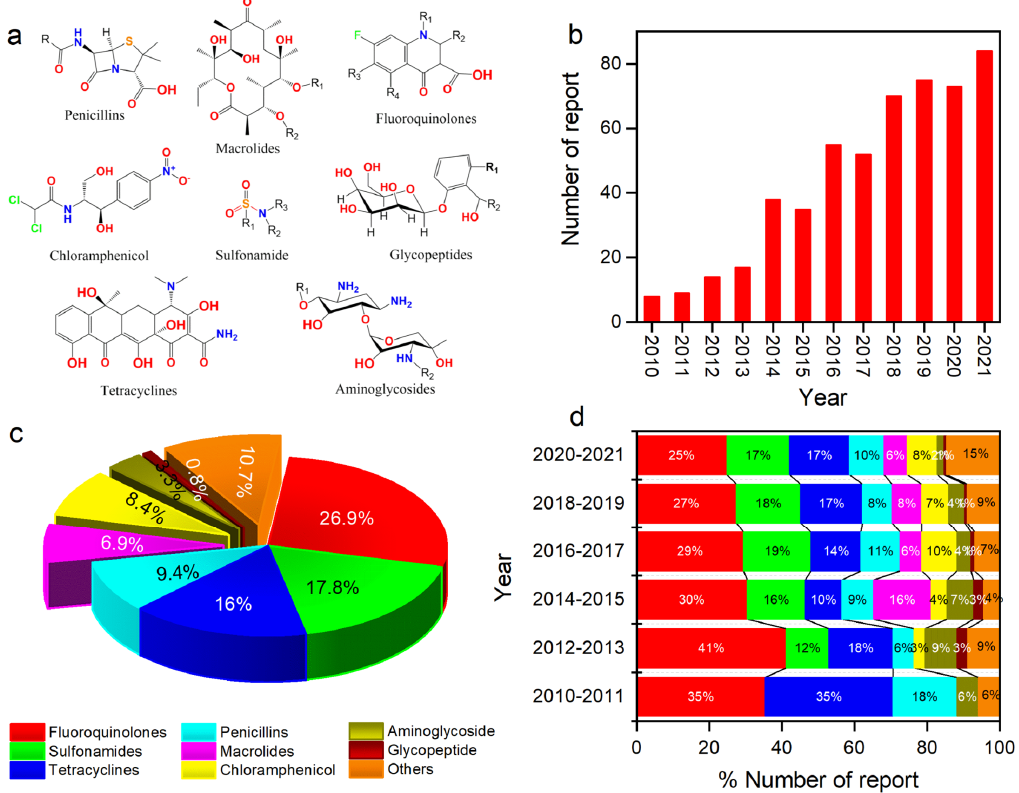
Figure 1. ( a ) Structures of antibiotics belonging to the different classes, ( b ) shares of peer-reviewed articles for different classes of antibiotics between the year 2010 and 2019, ( c ) yearly and ( d ) biannual reports of antibiotic imprinting research between the year 2010 and 2019 (Scopus 4 February 2022).